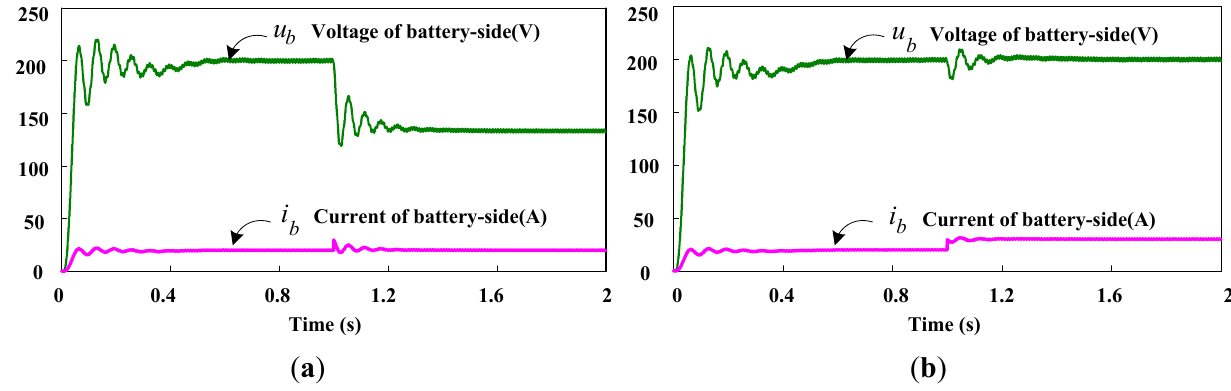
Figure 11. Output Simulated waveforms of battery-side. ( a ) Constant current charging mode; ( b ) Constant voltage charging